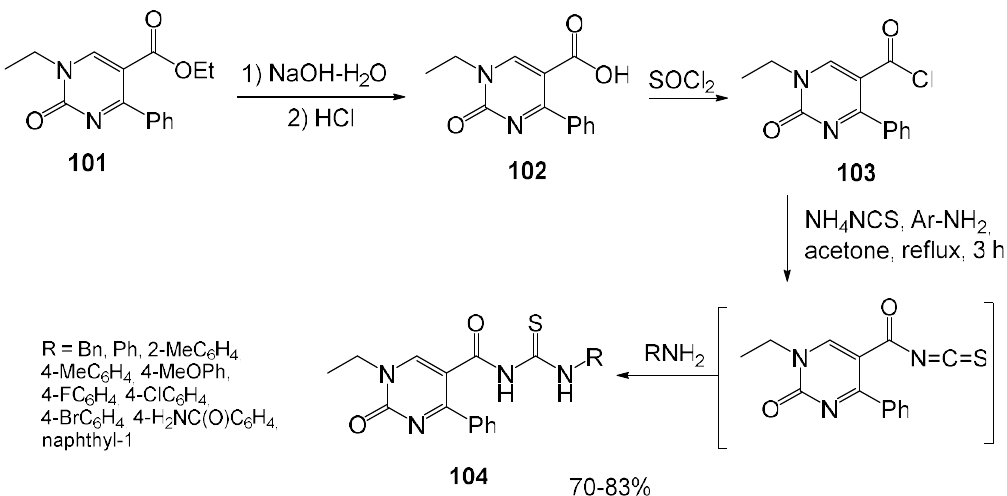
Fig. 27. Insecticide search strategy among 3-R-1-(3-chloropyridin-2-yl)-1 H -pyrazole-5-carboxylic acids with anthranylthioureides fragments